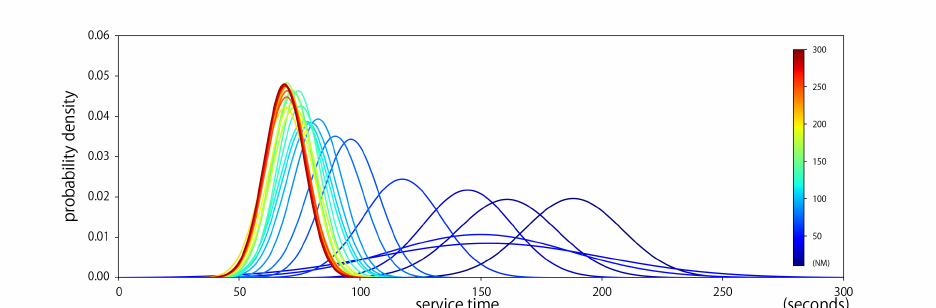
Figure 9. Distribution of service times for each area i with Gaussian fitting, where area i is a circular ring centered on the airport and bounded by concentric circles of radii 10 i and 10 ( i + 1 )